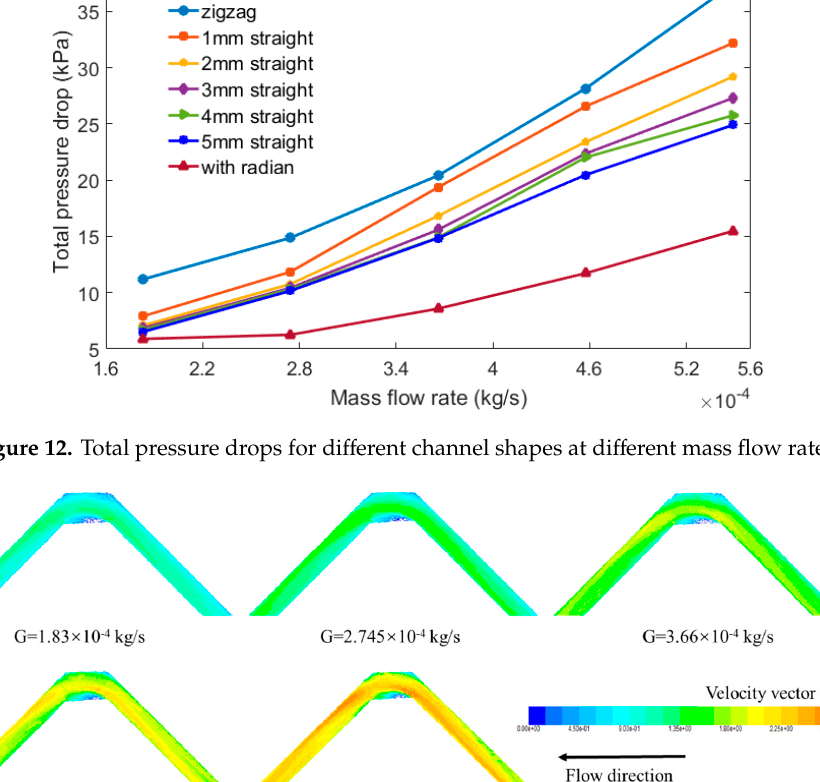
Figure 11. Nu of different channel shapes at different mass flow rates.